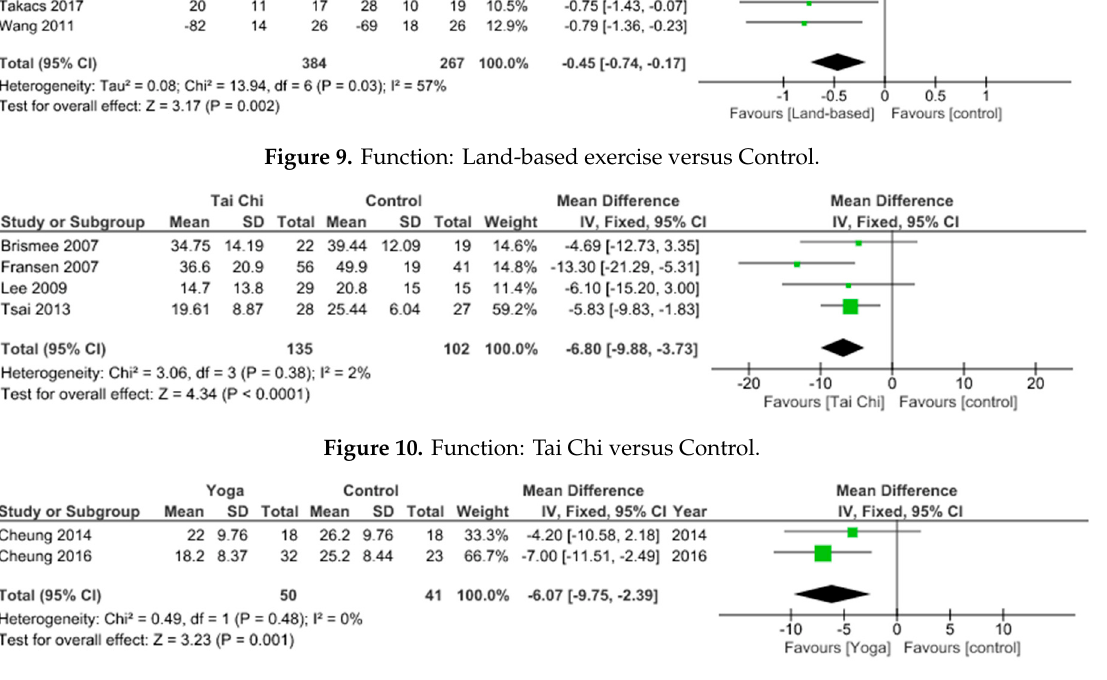
Figure 11. Function: Yoga versus Control.